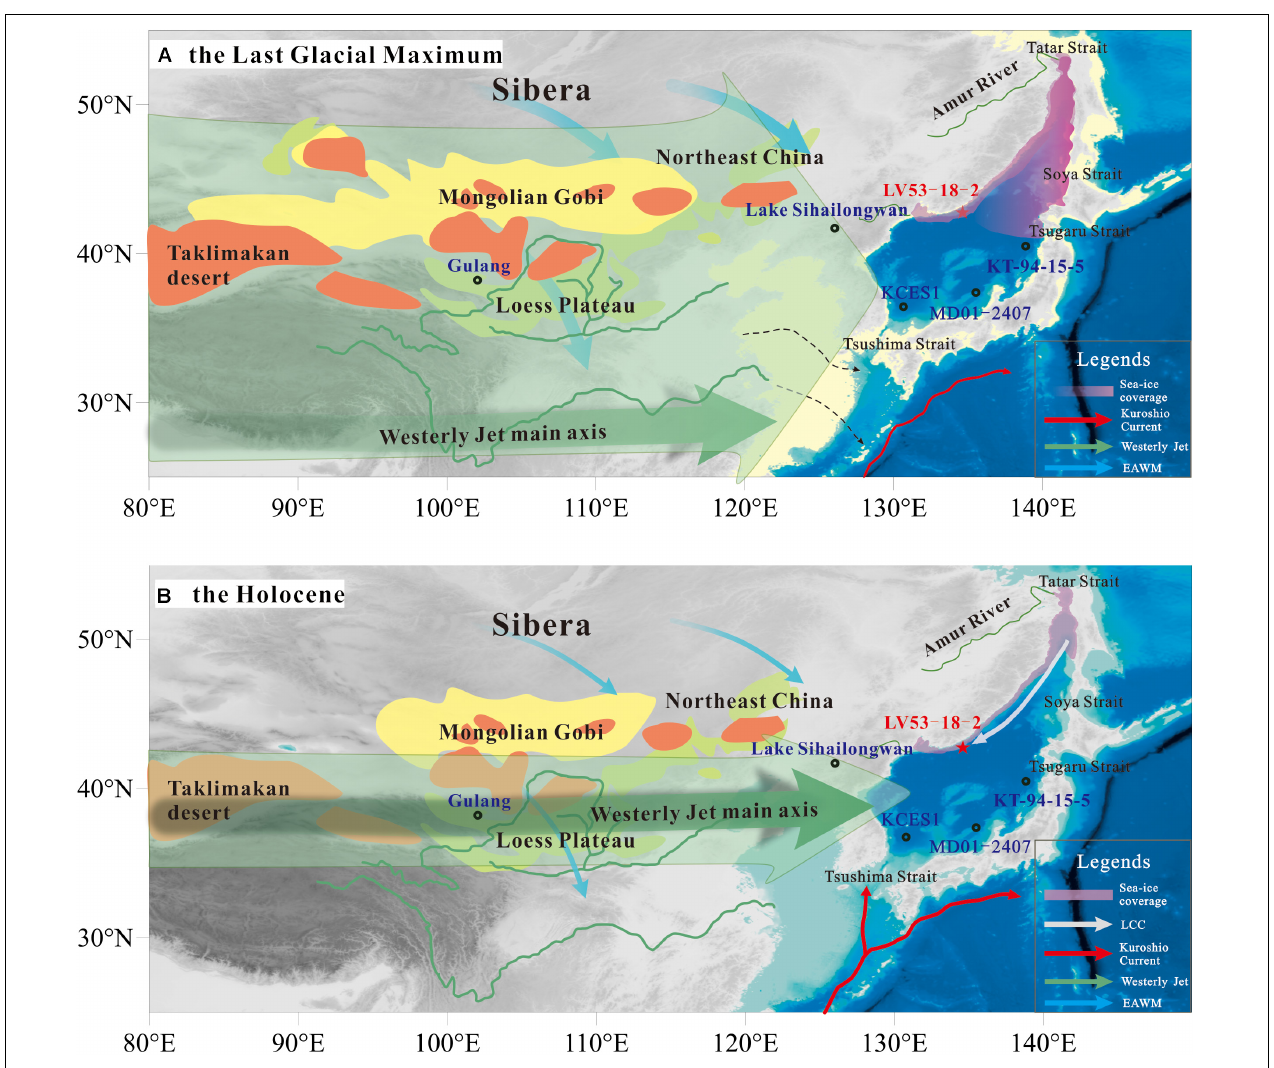
FIGURE 1 | Location map of core LV53-18-2 in the western Sea of Japan (A) during the Last Glacial Maximum (B) during the Holocene. Core KT94-15-5, MD01-2407 and KCES1 (Nagashima et al., 2007a; Zou et al., 2021) for comparison are shown in black hollow dots. Atmospheric circulation patterns, arid land over East Asian, oceanic current, and sea ice coverage influencing the Sea of Japan also are presented in this diagram which references (Nagashima et al.,